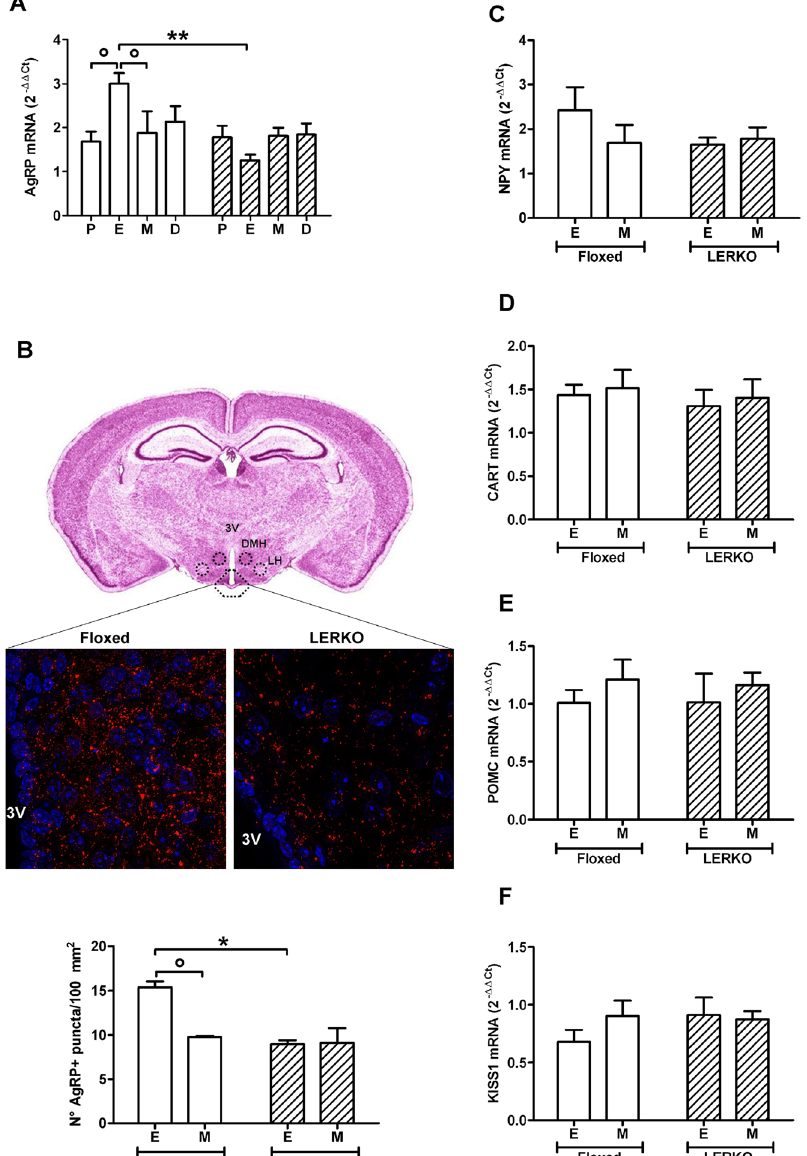
Figure 1. AgRP mRNA synthesis does not fluctuate during the estrous cycle in LERKO mice. AgRP mRNA measured by Real Time PCR in the hypothalamus of floxed and LERKO mice during the different phases of the estrous cycle, protestrus (P), estrous (E), metestrus (M) and diestrus (D) ( A ), representative images of AgRP staining in the arcuate nucleus of floxed and LERKO mice at E and quantification of AgRP positive synaptic puncta as evaluated by IHC for AgRP protein in the ARC of floxed and LERKO female mice at E ( B ), NPY mRNA ( C ), CART mRNA ( D ), POMC mRNA ( E ) and KISS1 mRNA ( F ) measured by Real Time PCR in the hypothalamus of floxed and LERKO female mice in E and M. 3 V = third ventricle. The image of the brain slice in Fig. 1B shows the areas used for the morphological analyses (from − 1.70 mm to − 1.58 mm from bregma) and is adapted from the web site: http://www.hms.harvard.edu/research/brain/atlas.html. The morphometric analysis was done as described in the methodology section. Data shown are the combined result of 2 separate experiments each with the following number of animals: rtPCR: n = 4 mice/exp for floxed, n = 8 mice/exp for LERKO. IHC: n = 3 mice/exp for floxed, n = 5 mice/exp for LERKO, Data are represented as mean ± SEM. Figure 1A: ** p < 0.01, two-way ANOVA followed by Bonferroni post hoc test, p = 0.0236, DF = 1, F = 5.84, LERKO vs floxed, °P < 0.05, p = 0.5918, DF = 3, F = 0.65, P vs E vs M vs D, but the interaction between the two variables is significant (p = 0.0284). Figure 1B: * p < 0.05, two-way ANOVA followed by Bonferroni post hoc test, p = 0.0342, DF = 1, F = 6, LERKO vs FLOXED, °p < 0.05, unpaired two-tailed t-test, p = 0.0147, DF = 1, t = 8.161, E vs M. Figure 1C: p = 0.3076, DF = 1, F = 1.09, LERKO vs floxed, p = 0.3555, DF = 1, F = 0.89, Fig. 1D: p = 0.5608, DF = 1, F = 0.36, LERKO vs floxed, p = 0.6709, DF = 1, F = 0.19, E vs M, Fig. 1E: p = 0.9114, DF = 1, F = 0.01, LERKO vs floxed, p = 0.3957, DF = 1, F = 0.79, E vs M, Fig. 1F: p = 0.4722, DF = 1, F = 0.54, LERKO vs floxed, p = 0.5109, DF = 1, F = 0.45, E vs